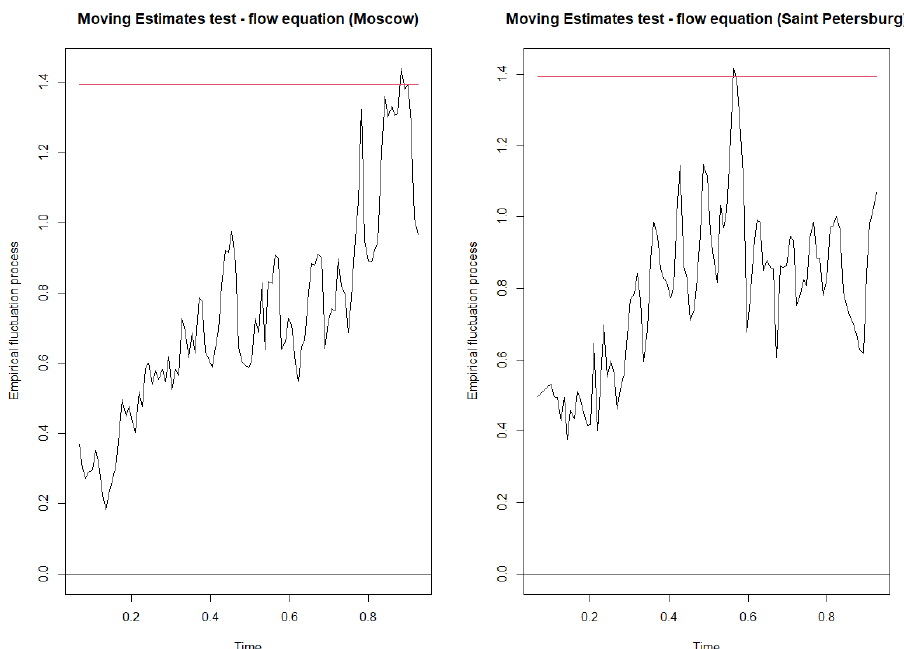
Figure A6. Fluctuation test based on the moving OLS estimates for the VAR equation of the monthly migration flow in Moscow and Saint Petersburg, with the boundary for the 5% confidence level (red line). The standardized sample cover the period 2009–2020.